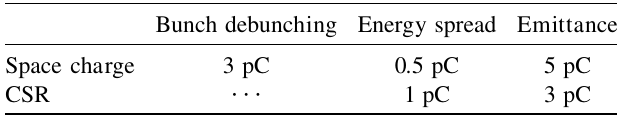
Microbunch charge threshold for STELLA-II.